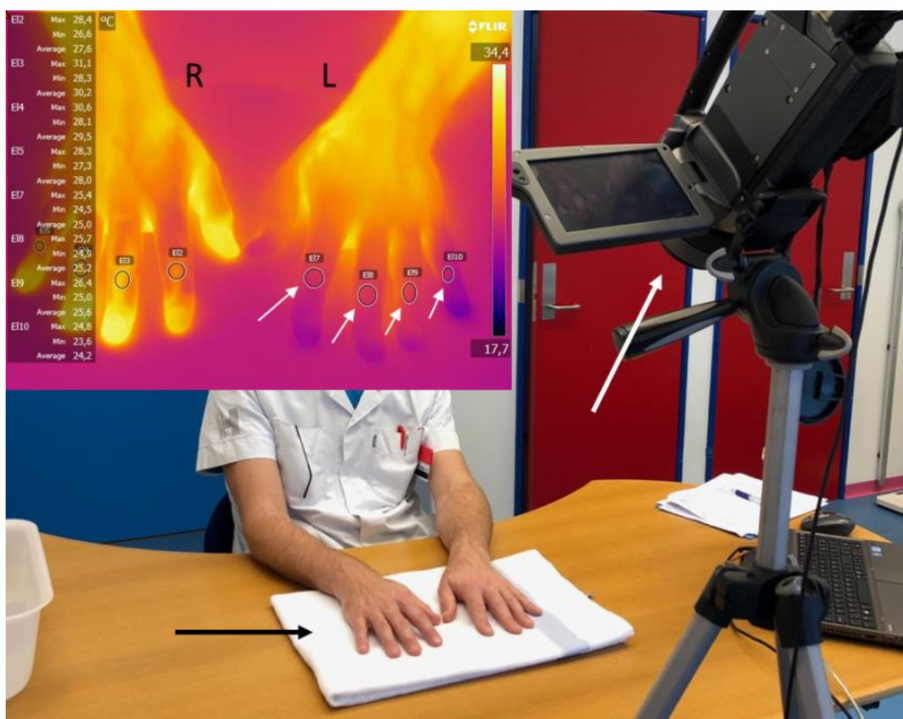
Figure 1. The thermographic examination setup with the infrared thermographic camera (large white arrow). R = right, L = left. After the cold challenge, the hands were left to rewarm on a towel (black arrow). The thermographic image illustrates the hands during rewarming. The small white arrows mark the elliptical area of interest on the middle phalanx of each investigated finger on the left hand. Both hands were